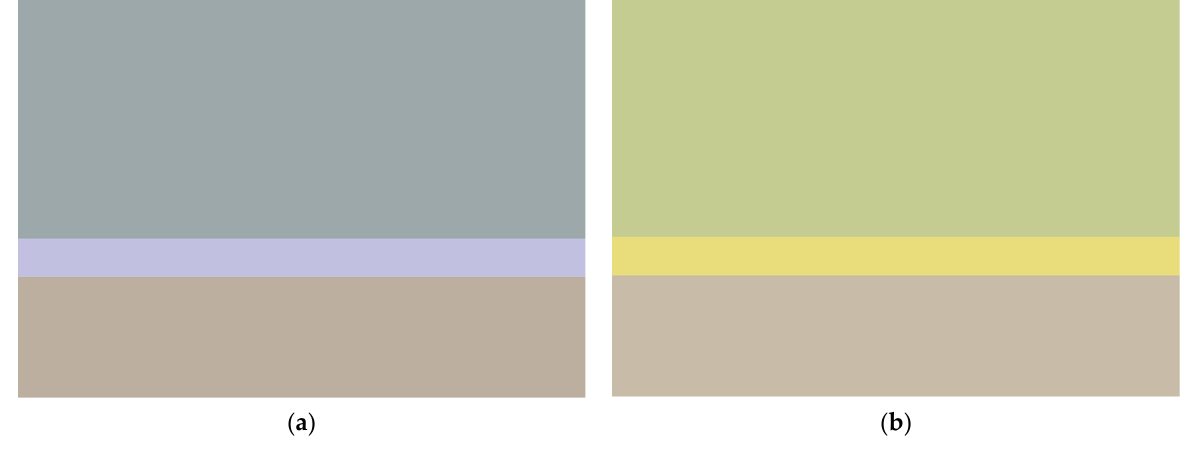
Figure 11. Charts 26 ( a ) and 27 ( b ) from Section IV.